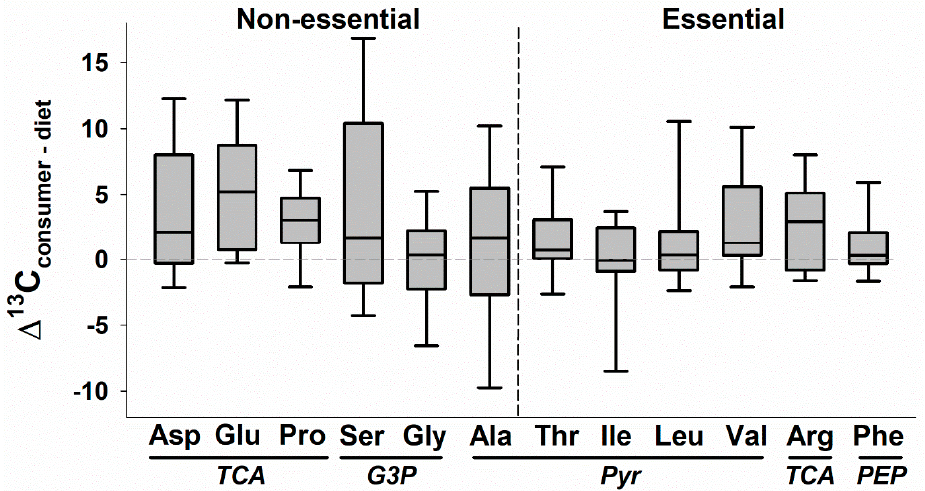
Figure 3. Median values (solid line; boxes and error bars represent 25th and 10th percentiles) of the carbon isotope discrimination factors ( Δ 13 C C-D , or δ 13 C Consumer tissue − δ 13 C Diet item ) for individual amino acids (AA) across nine species of animals consuming a total of 24 different diets in controlled experiments. AA that are essential tend to have reduced variation and values closer to 0 ‰ in comparison to those that are non-essential. Note that Arg is conditionally essential, and Gly is essential for birds. AA are also grouped by the source of precursor molecules for biosynthesis: TCA = intermediates of the tricarboxylic acid cycle; G3P = glycerate-3-phosphate of glycolysis; Pyr = pyruvate; PEP = phosphoenolpyruvate of glycolysis. Note that of the 20 standard AA, four are excluded here because they are usually not measured (histidine, methionine, tryptophan, cysteine) and two are excluded because they have been reported in only one study of which we are aware (lysine, tyrosine; [72]). In addition, during sample preparation, glutamine is converted to glutamic acid and asparagine to aspartic acid. Studies were located by (1) searching the references cited in a recent review of AA ∆ 15 N C-D [31]; (2) searching “Web of Science” electronic database for “carbon isotope” and “amino acid”; and (3) searching citations of relevant publications. Studies are listed in Table S1.